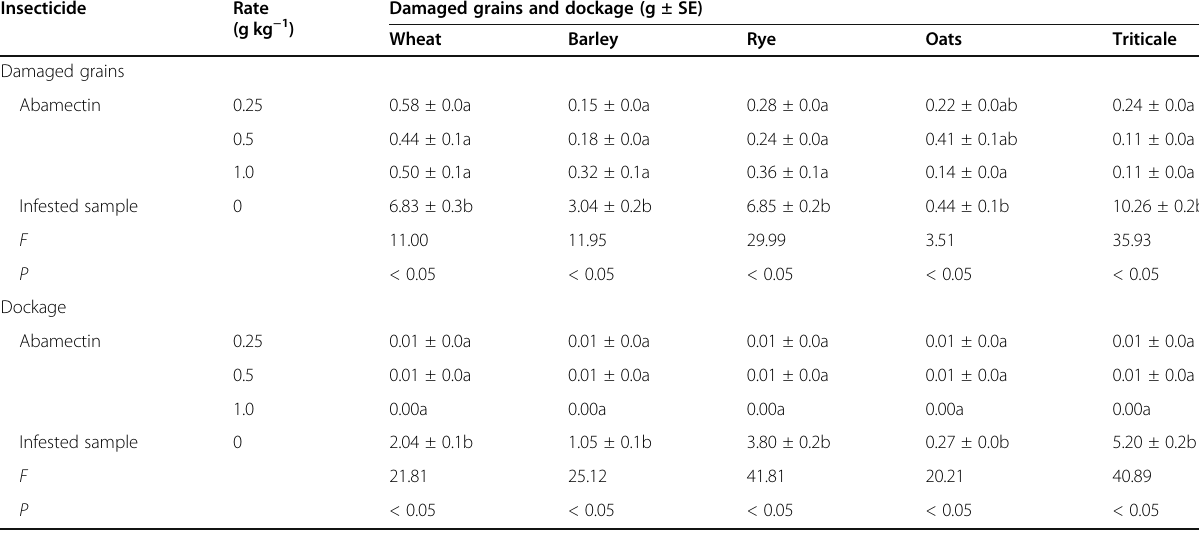
Table 4 Amount of insect-damaged grains and dockage (g ± SE), 10 weeks after the treatment of 5 grain species with abamectin Insecticide Damaged grains Abamectin